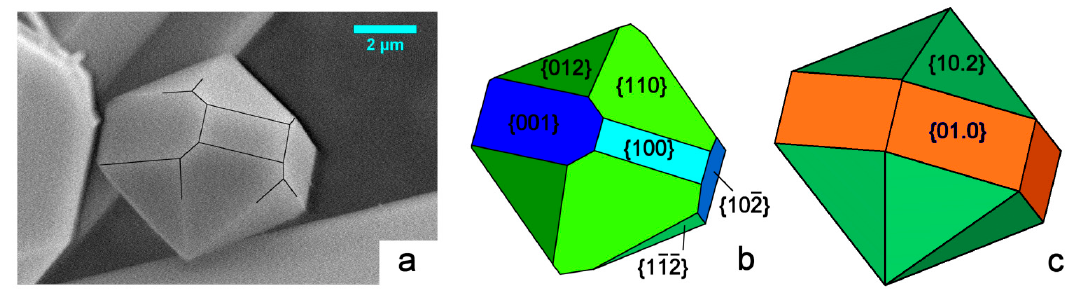
Figure 3. ( a ) SEM picture of our HAp crystal grown under mild hydrothermal conditions. It belongs to the monoclinic polymorph, and shows three consecutive pinacoids: {001}, {100} and {102}, all parallel to the [010] zone axis, along with the three corresponding prisms: {012}, {110}, and {112}, as drawn in ( b ); where the theoretical (2/m) morphology is represented with different sizes and colors associated to different crystallographic forms. The theoretical (6/m) morphology is drawn in ( c ). It is related to the space group P6 3 /m, with the [001] direction parallel to the 6 3 axis. The comparison between the three frames makes evident that the growth shape of the monoclinic polymorph could be easily confused with the hexagonal one.